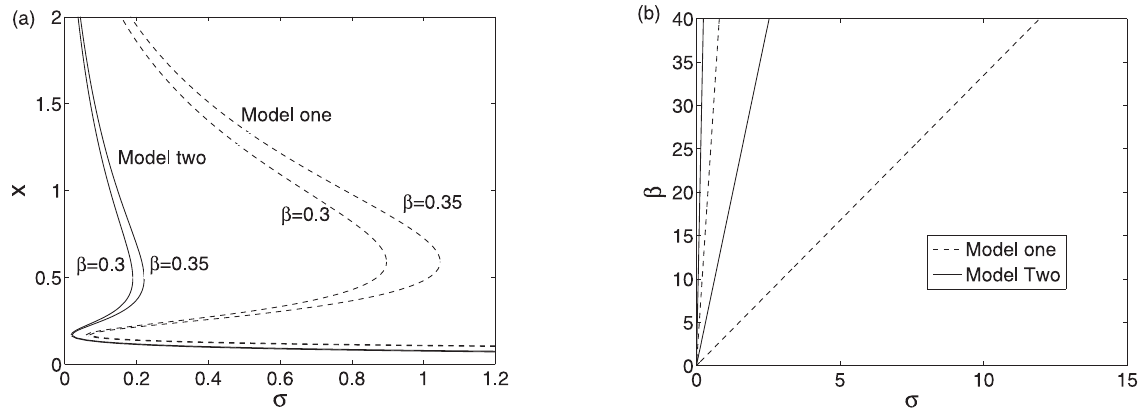
Figure 7. The bifurcation diagrams of the two models at l ~ 0 : 5 . (a) The bifurcation diagrams with s as the control parameter. (b) The bifurcation diagrams with s and b as control parameters. Other parameter values are the same as those used in Fig. 5.